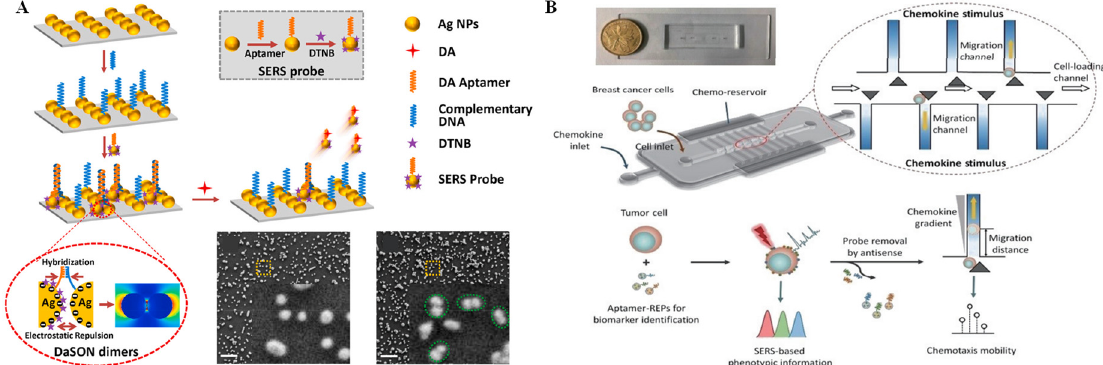
Figure 2. SERS technique and applications. ( A ) Schematic diagram and SEM images of dopamine detection based on SERS sensors. Reprinted with permission from ref. [48], Copyright 2021, Elsevier B. V. ( B ) Schematic of the chip design and the working principle of on-chip 2D phenotype profiling of tumor cells. Reprinted with permission from ref. [49], Copyright 2022, Tsinghua University